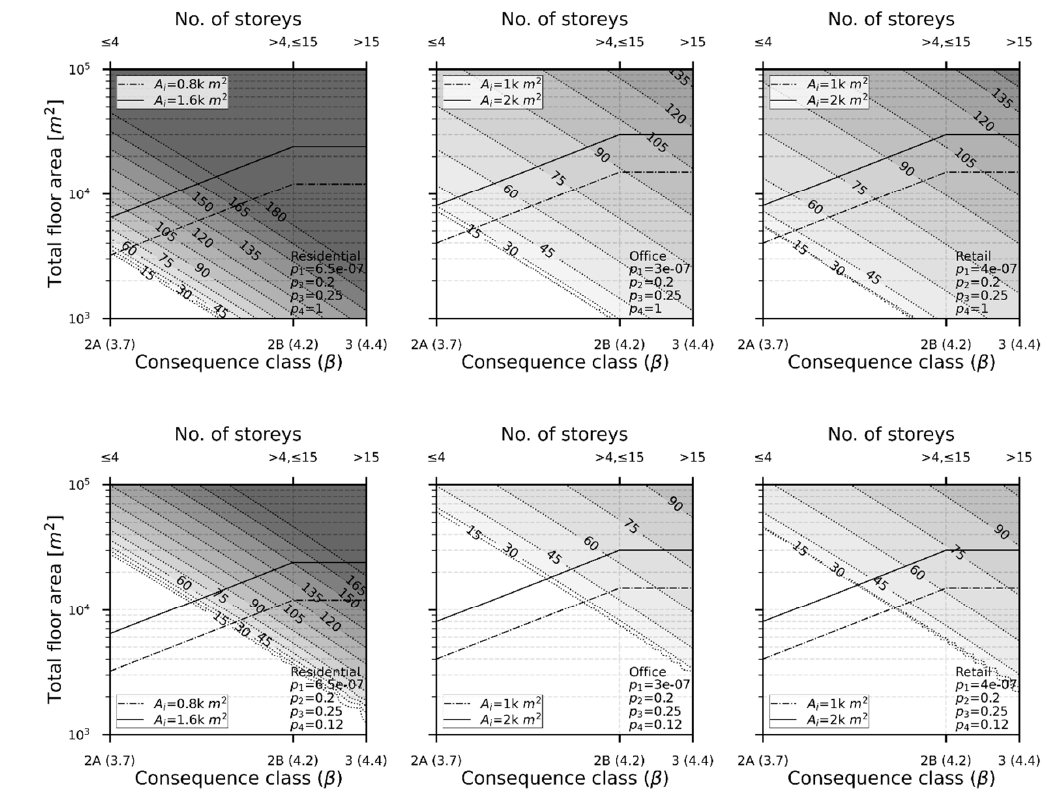
Figure 3. Contour plots of the solved structural fire-resistance rating at various building heights and total floor area (without and with sprinklers); A i denotes floor area per storey. Table 10 tentatively maps consequence class-based fire resistance recommendations as given in Figure 3 to height related recommendations as presented in BS 9999:2018. The values in brackets correspond with cases where sprinkler protection is provided. Table 10. Minimum required fire resistance periods, a comparison between those derived based on JCSS cost-optimised reliability targets and recommendations in contemporary guidance.